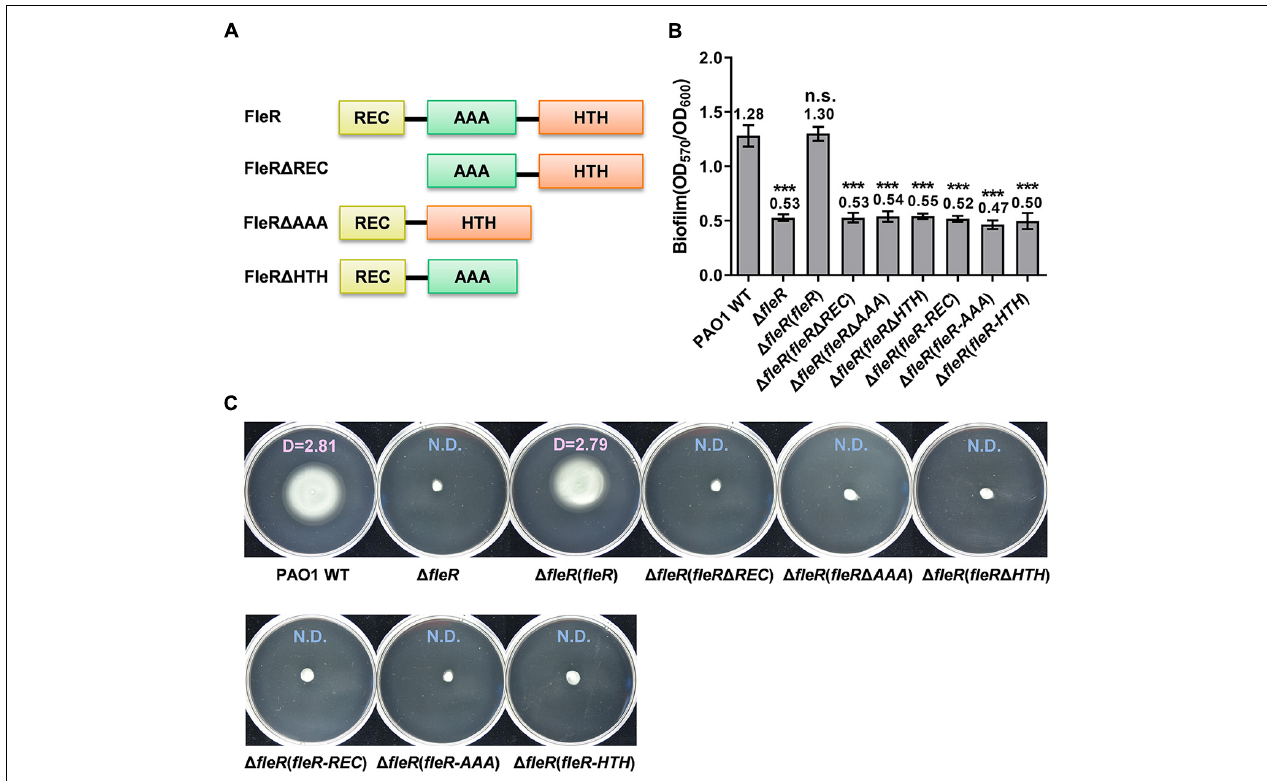
FIGURE 2 | REC, AAA, and HTH domains in FleR are all essential to control biofilm formation and swimming motility. (A) A schematic diagram showing the domain structures of FleR and its variants. (B) Biofilm formation of the PAO1 wild type (WT), the (cid:49) fleR mutant and the (cid:49) fleR mutant with ectopic expression of FleR, FleR (cid:49) REC, FleR (cid:49) AAA, FleR (cid:49) HTH as well as the single FleR domains FleR-REC, FleR-AAA, and FleR-HTH. The result is shown as the mean of five replicates per strain and error bar indicates the standard error of mean (SEM). *** P < 0.001, n.s., no significance (Student’s t -test). (C) Swimming motility of the PAO1 wild type, the (cid:49) fleR mutant and the (cid:49) fleR mutant with ectopic expression of FleR, FleR (cid:49) REC, FleR (cid:49) AAA, FleR (cid:49) HTH, FleR-REC, FleR-AAA, and FleR-HTH. Representative images and the average diameter (D) of the swimming migration zone of each strain are shown. N.D., not detected. Each experiment was performed in